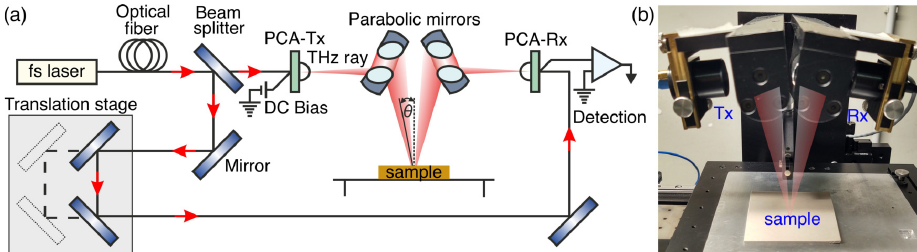
Figure 1. ( a ) Schematic of the employed THz-TDS setup, configured for sample characterization in reflection mode. The setup consists of an fs-pulse, near-infrared laser, photoconductive transmit (Tx) and receive (Rx) antennas, an optical delay line, a set of mirrors, and the sample under test placed on a metallic baseplate. The optical beam path is marked with red arrows and the THz wave path by red-shaded elements. ( b ) Photo showing the THz-wave propagation module of the TDS setup with a sample placed on the metallic